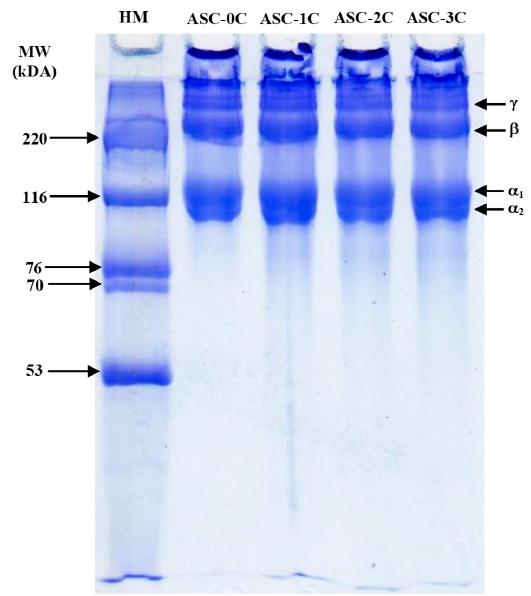
Figure 3. Protein pattern of acid-soluble collagen from salmon skin prepared by washing the collagen pellet using distilled water for different cycles. HM: High molecular weight marker (220, 116, 76, 70 and 53 kDa); MW: Molecular weight. γ , β , α 1 and α 2 denote trimer, dimer, α 1 and α 2 chains, respectively. For the caption, see Figure 2.